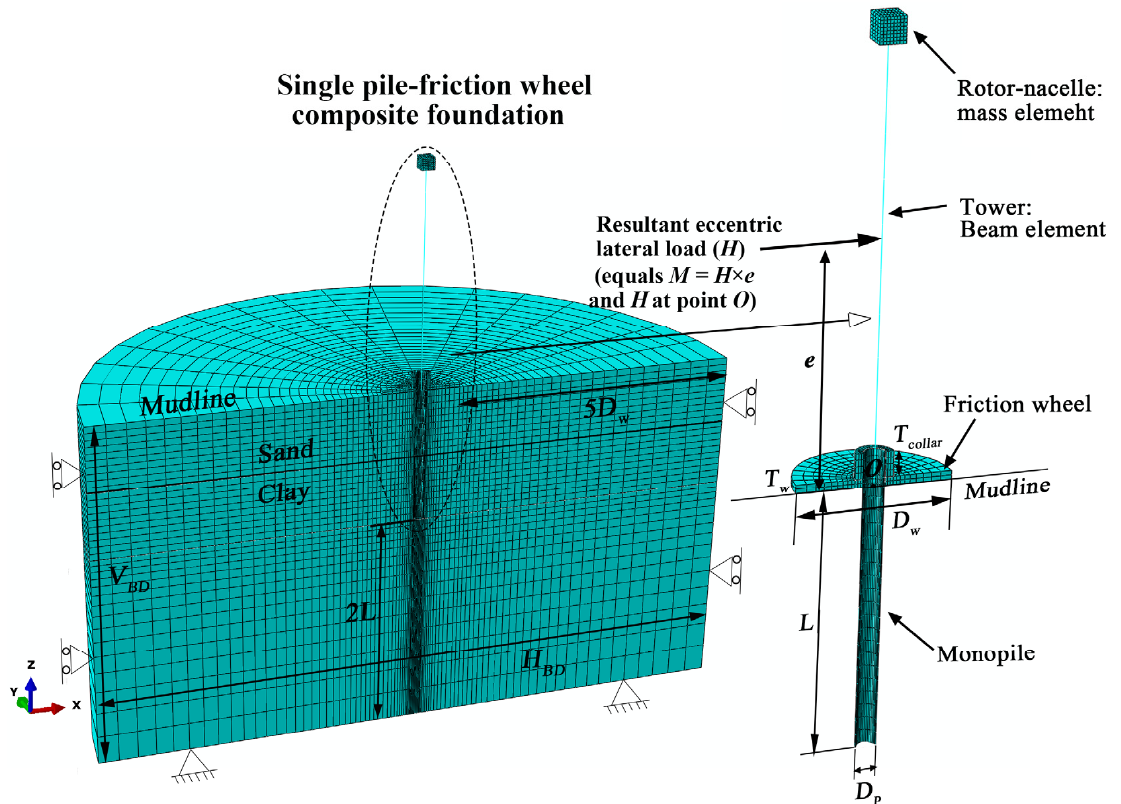
Figure 2. Geometry and mesh of the single pile-friction wheel composite foundation models.